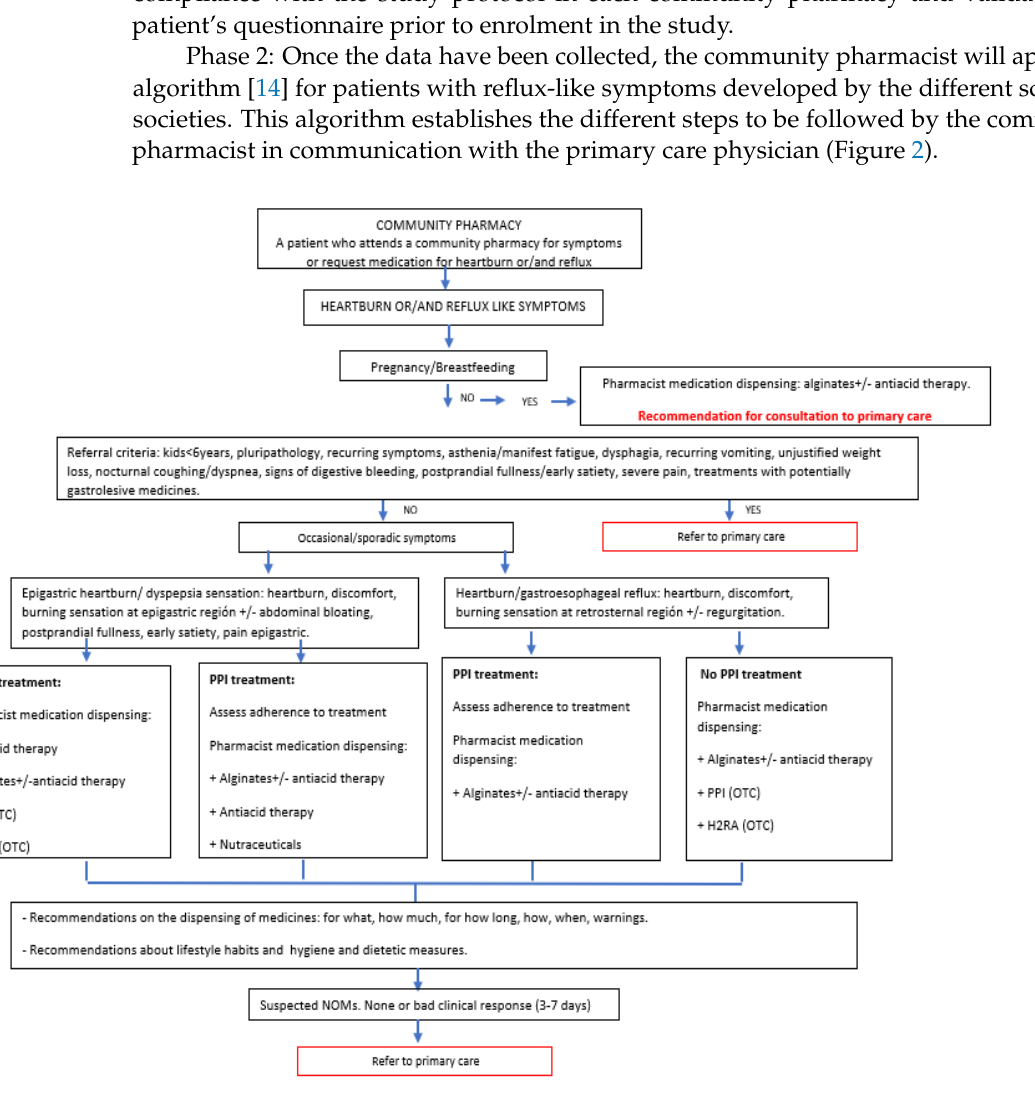
Figure 2. Heartburn and/or reflux-like symptom management algorithm in community pharmacy.